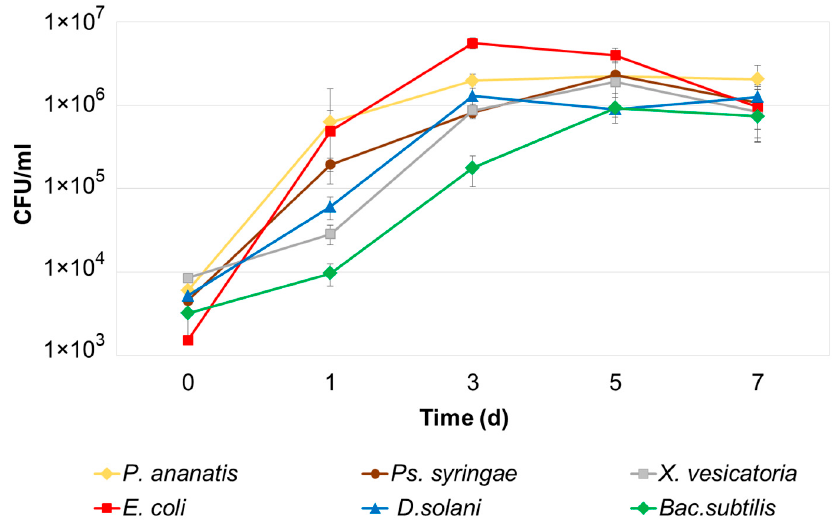
Figure 6. The dynamics of the colony forming unit (CFU) titer in the starving cultures of Pantoea ananatis (yellow line), Pseudomonas syringae (black line), Xanthomonas vesicatoria (grey line), Escherichia coli (red line), Dickeya solani (blue line), and Bacillus subtilis (green line). Cultures were incubated in a carbon-deficient medium at low initial population densities (2–9 × 10 3 CFU/mL). The presented values are the means ± SD of three biological replicates.